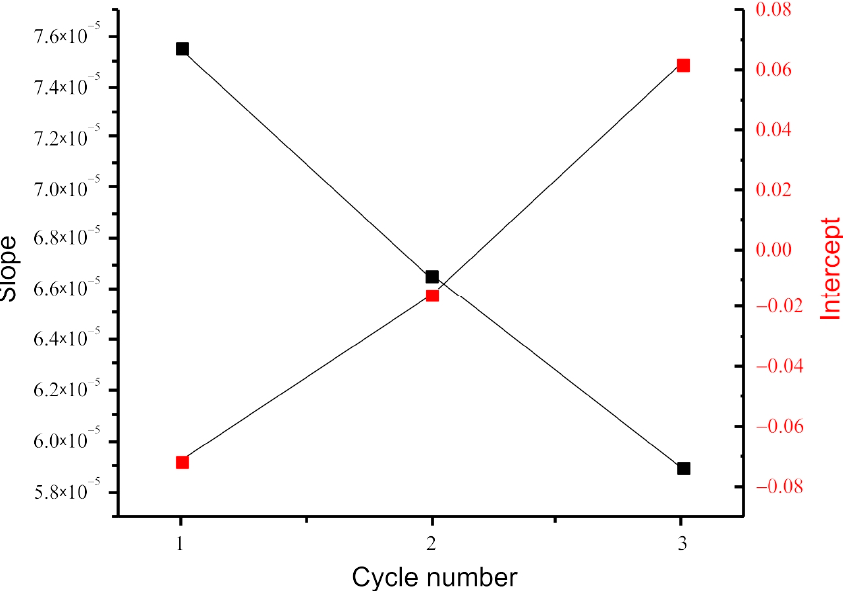
Figure 5. Dependences of the parameters of linear regressions on the cycle number of voltage change.